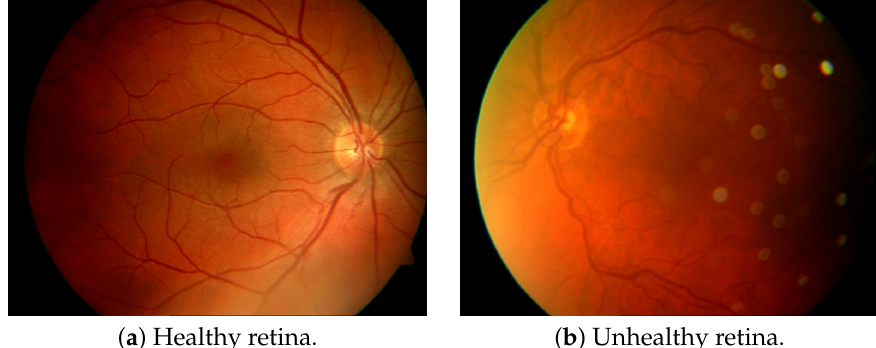
Figure 2. Visualization of a healthy retina and an unhealthy retina